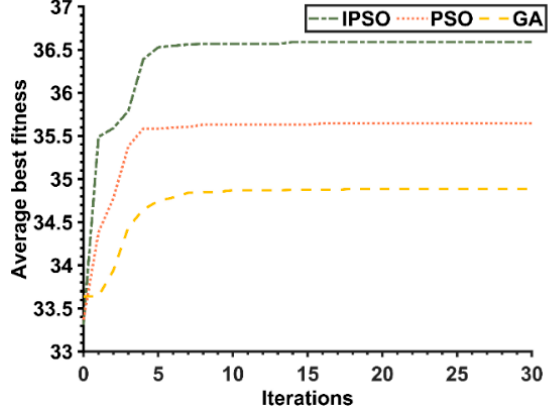
Figure 8. Average best fitness of the IPSO, PSO, and GA changed with iterations.